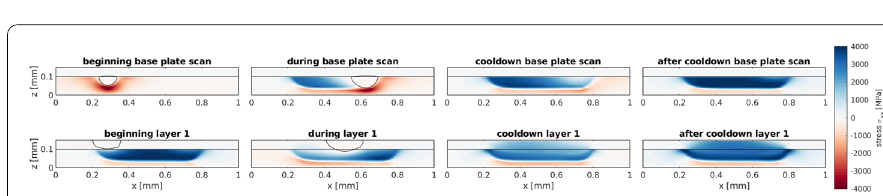
Fig. 19 Modified scenario: scanning base plate and layer 1. Detailed view of the evolution of the longitudinal stress σ xx in the symmetry plane. Blue color represents tension, red color represents compression. Liquidus isotherm (solid black line) approximates melt pool shape. Time progresses from left to right and top to bottom. For improved visibility of the relevant stresses the color bar is rescaled